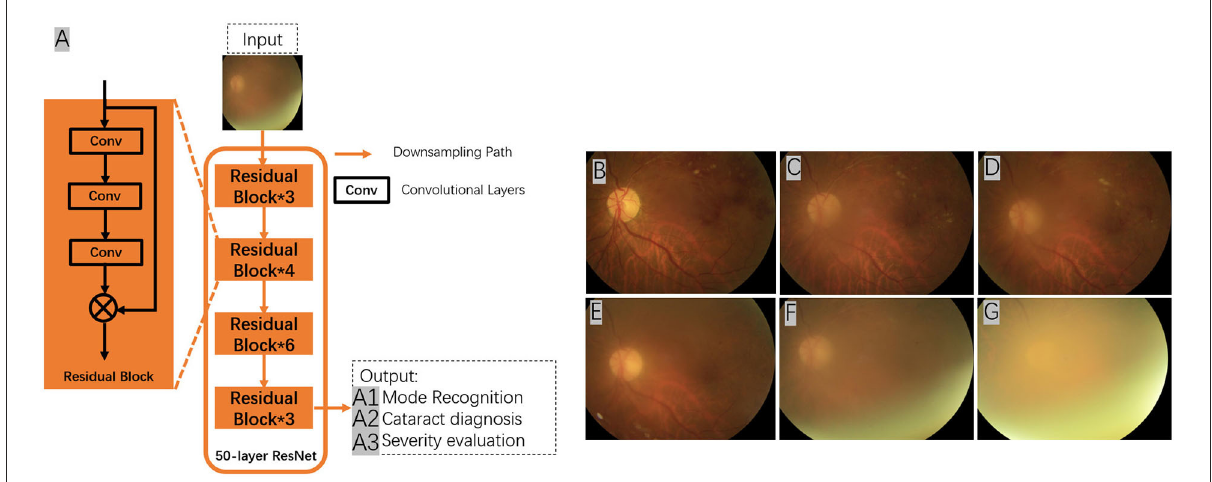
FIGURE2 Using deep residual network (ResNet) for cataract recognition and grading. The overall architecture of the ResNet consists of 16 residual blocks and each residual block consists of three convolutional layers. The output of the ResNet includes: (A1) mode recognition - identify the capture mode between mydriatic and non-mydriatic images, and between optical section and diffuse slit lamp illimitation; (A2) cataract recognition - the system could classify the images as normal (no cataract), cataractous, or postoperative intraocular lens (IOL); and (A3) severity evaluation - classify the type and severity of the cataract (A–G) , and assess the subsequent follow-up or referral arrangements for the patient. Conv, convolutional